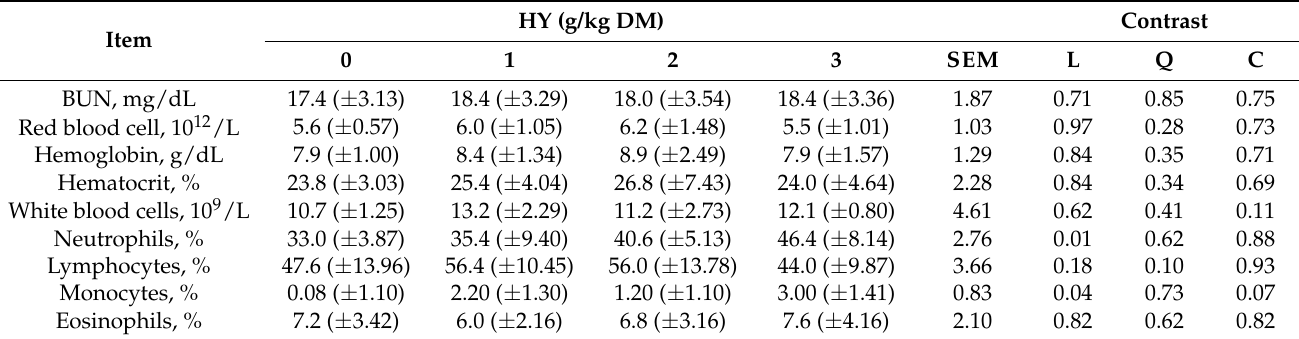
Table 6. Effect of HY supplementation on hematology in growing beef